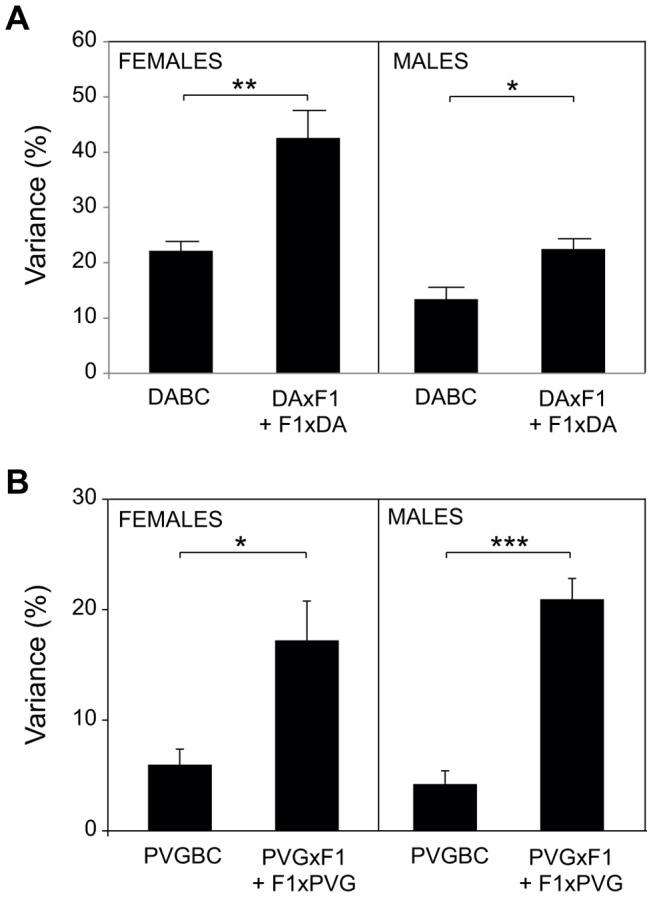
Accounting for parent-of-origin effects improves disease inheritance models.Phenotypic variance (%) that can be explained by risk loci is greatly increased when parent-of-origin effects are included, supporting their contribution to EAE. The fit multiple-QTL model was used to validate the independent effects of each QTL (phenotype  =  QTL1 + QTL2 + … + QTLn +ε) (Table S1, Table S6). A) Mean variance of all phenotypes +/− SEM is presented for the entire DABC and as a sum of variance for each reciprocal cross (DAxF1) + (F1xDA). Due to the high severity in DABC males, the severity phenotypes are omitted. B) Mean variance of all phenotypes +/− SEM is presented for the entire PVGBC and as a sum of variance for each reciprocal cross (PVGxF1) + (F1xPVG).*, ** and *** indicate p<0.05, 0.01 and 0,001, respectively.